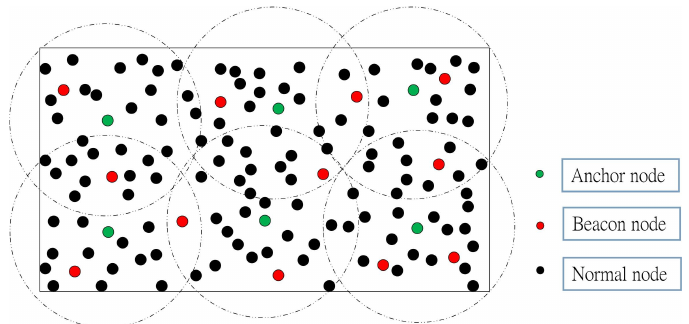
Figure 1. Example of node deployment strategy in the localization